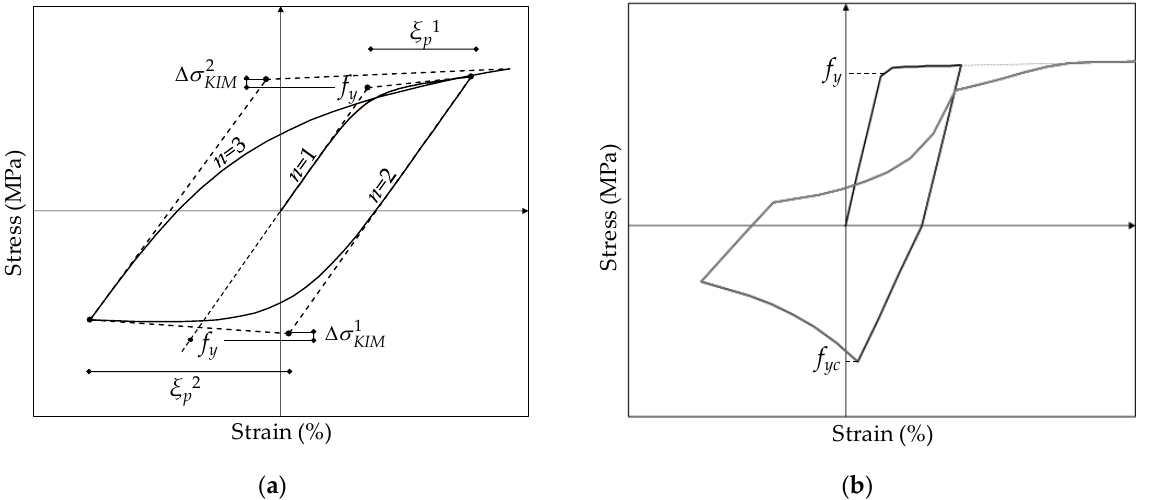
Figure 1. Constitutive law for steel including buckling: ( a ) Monti and Nuti model and ( b ) Kashani et al. model. The yield stress, both in tension and in compression, referred to the n +1 half-cycle, σ n + 1